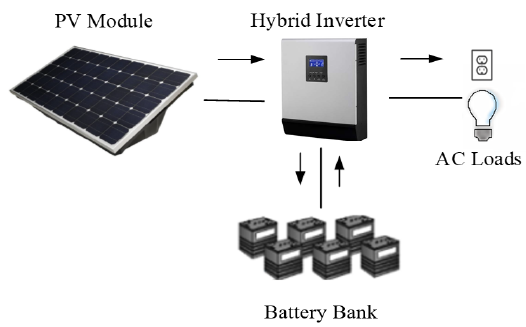
Figure 5. PV system components and configuration based on the concept.